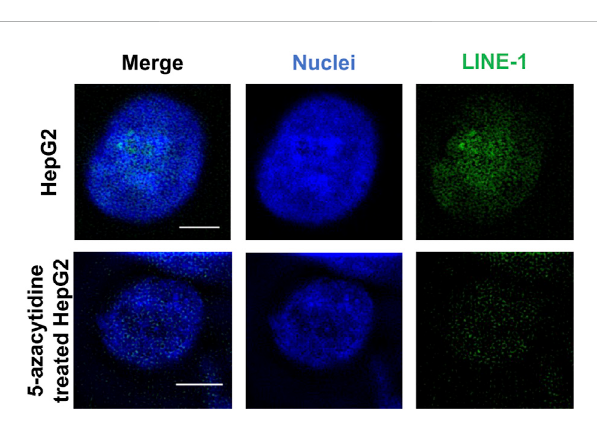
FIGURE 3 MeFISHimagesofLINE-1(green)innormalHepG2cells(blankcontrol) and HepG2 cells treated with 1 μ M 5-azacytidine, which inhibits DNA methylation. The nuclei were labelled by DAPI (blue). Scale bars, 5 μ LINE-1 was successfully imaged and analyzed (Figure 3). Conversely, the LINE-1 methylation level of HepG2 cells treated with 1 μΜ 5- azacytidine, which inhibits DNA methylation by trapping DNMT and